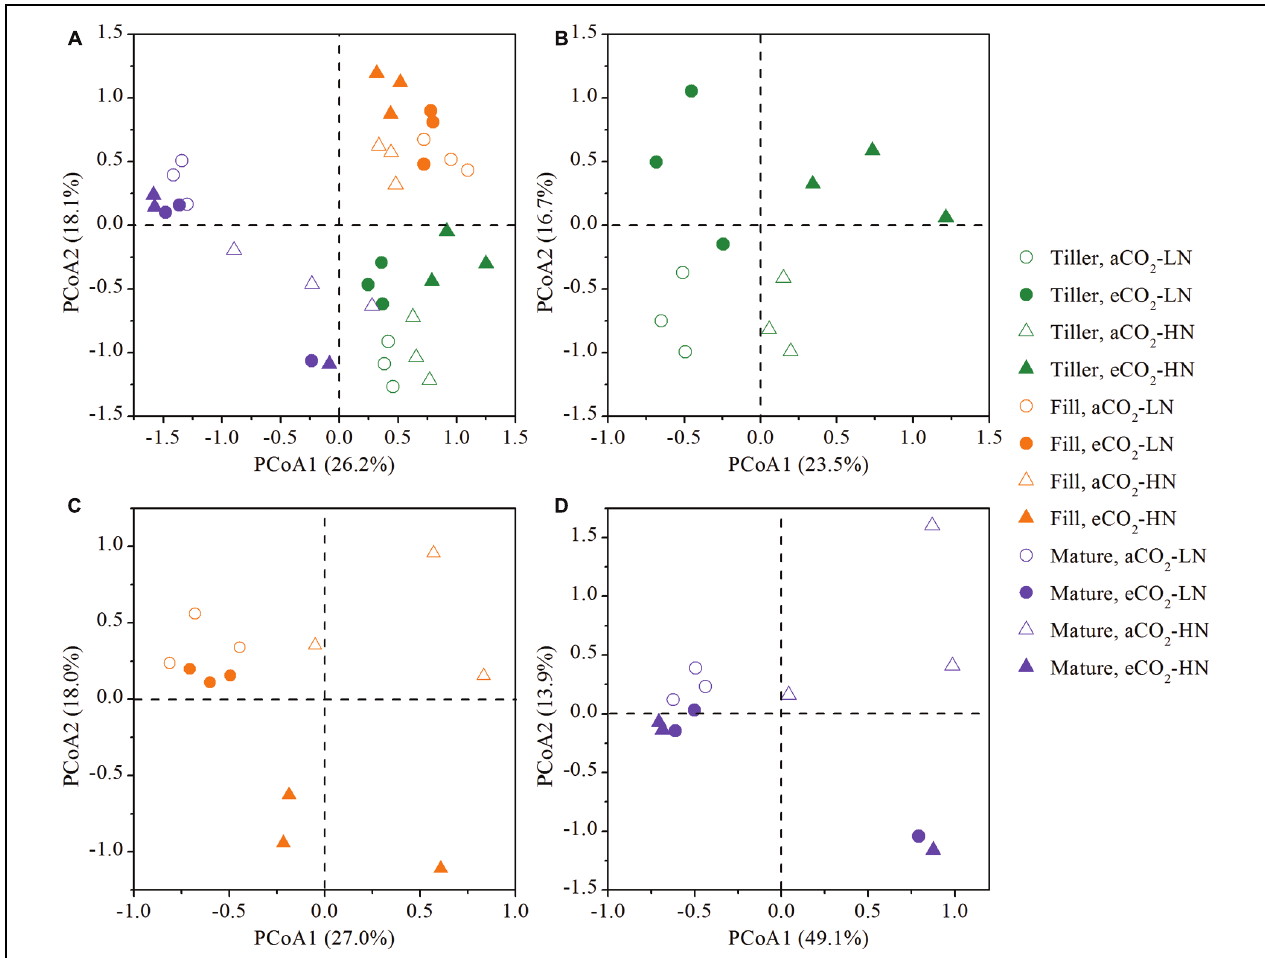
FIGURE 3 | Principal coordinates analysis (PCoA) of microbial communities from all samples (A) or those samples collected at the tillering (B), filling (C), and maturity (D) stages, respectively. The percentage in parentheses denotes the proportion of variation explained by each ordination axis. All other designations are the same as those in Figure 1